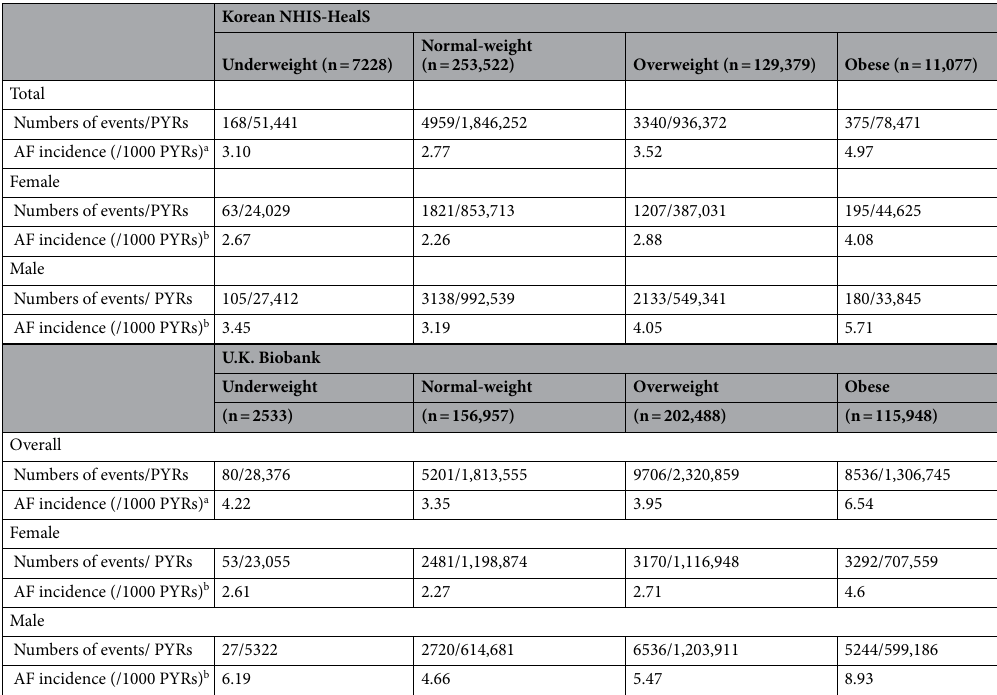
Table 2. Age- and sex-adjusted incidence of AF by BMI in the Korean NHIS-HealS Cohort and the U.K. Biobank Cohort. NHIS-HealS National Health Insurance Service’s Health Screening, PYRs person-years. a Sex- and age-adjusted AF incidence. b Age-adjusted AF